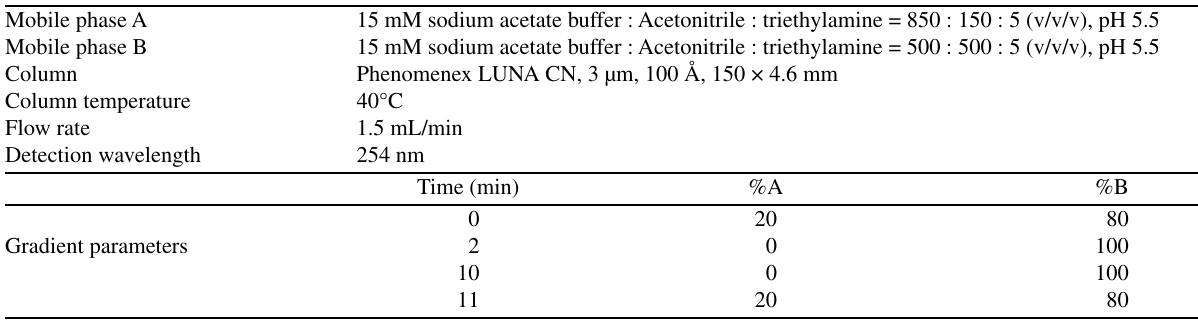
Table 1. Chromatographic conditions of the initial HPLC method for assay determination of BKC. Mobile phase A